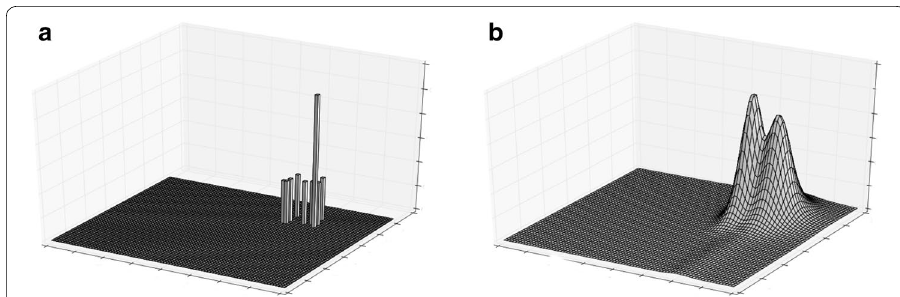
Fig. 3 Smoothing a histogram with Gaussian kernels. a Original histogram. b Smoothed